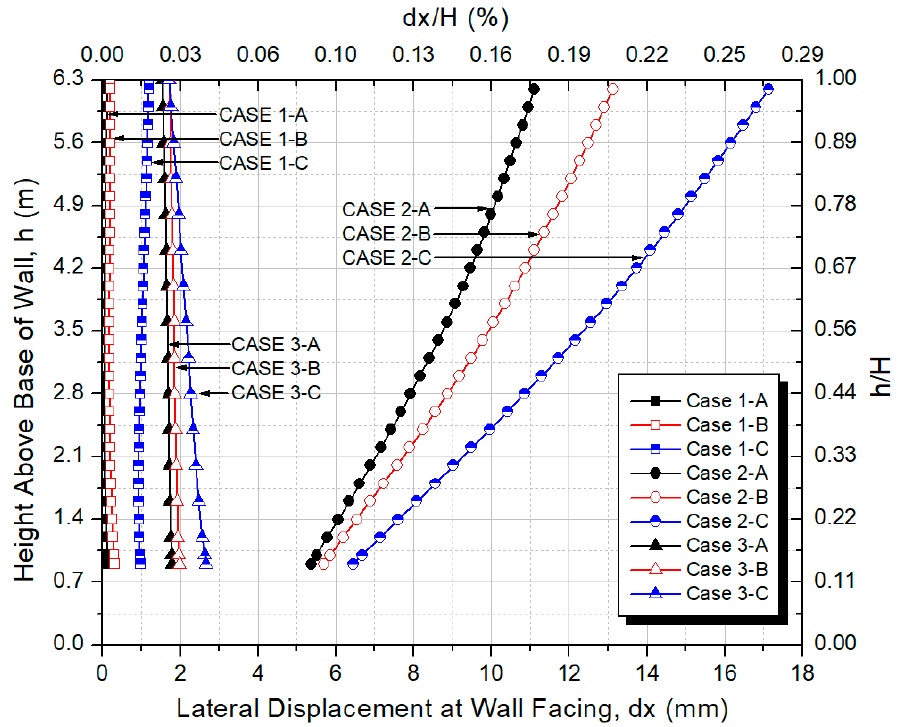
Figure 7. Lateral displacements at the wall facing, dx (mm), when models are subjected to different static loadings: Case 1A, 2A, 3A (end of bridge construction); Case 1B, 2B, 3B (applied general traffic loading); and Case 1C, 2C, 3C (applied railway